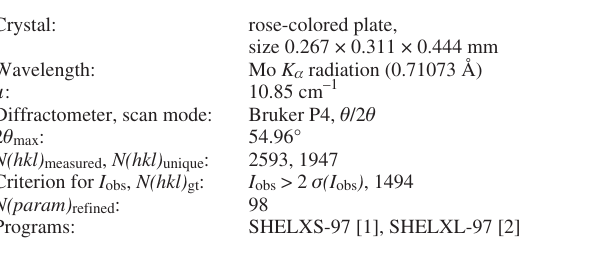
Table 1. Data collection and